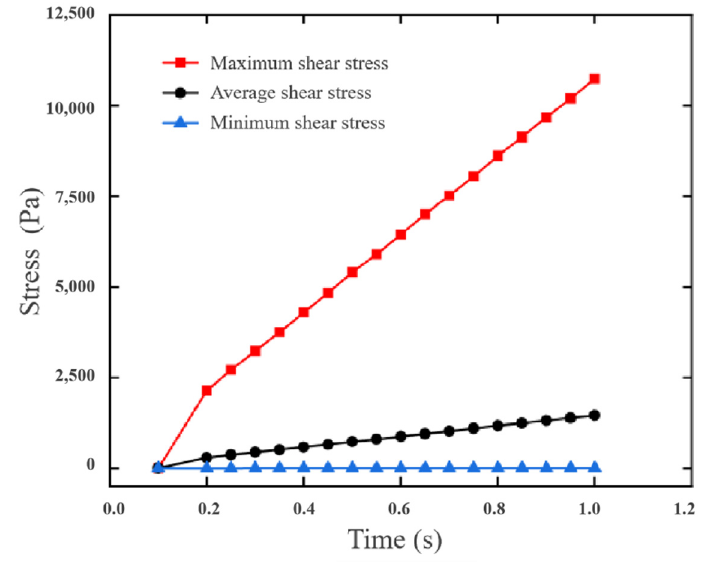
Figure 19. Variation of wall shear stress on the stent, with time, in a single cycle.